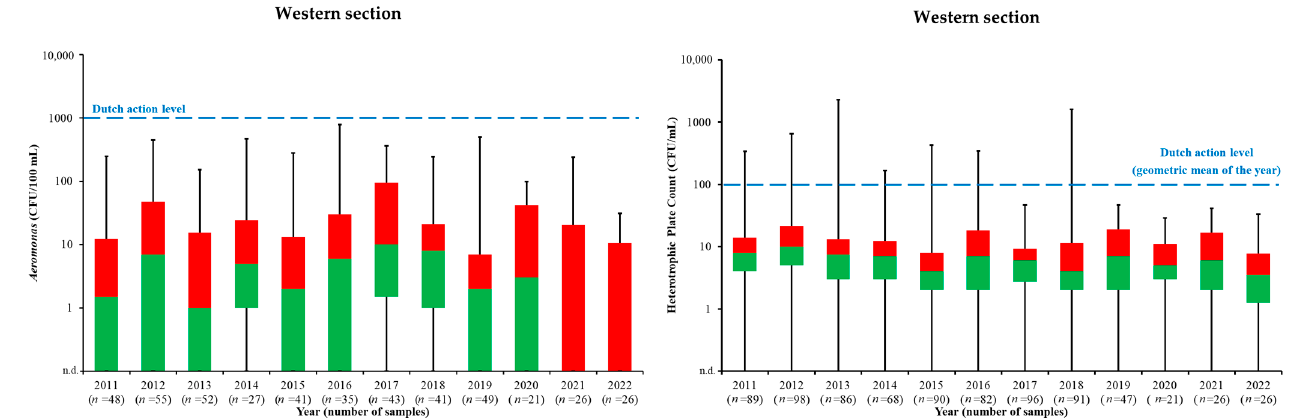
Figure 6. Boxplots of Aeromonas ( Left ) and HPC22 ( Right ) in the western section of DWDS Zeeuws-Vlaanderen.  : second quartile;  : third quartile; T : first and fourth quartile; n.d.: not